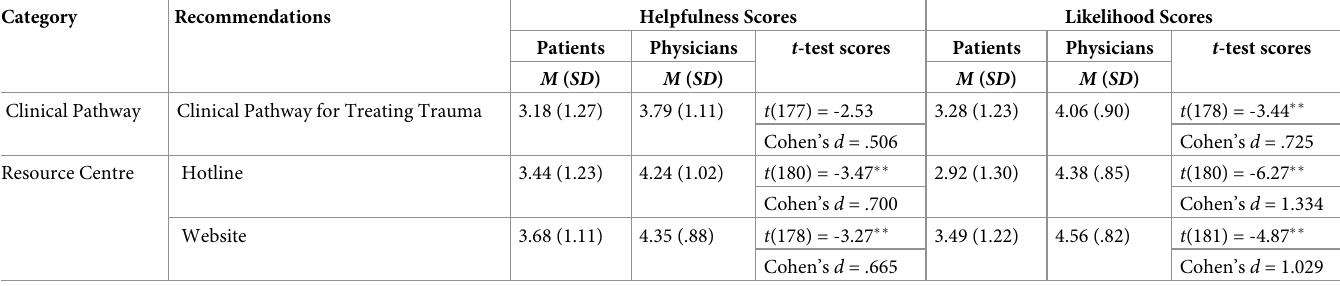
Table 8. Independent t -tests comparing patients’ and physicians’ scores on clinical pathway and trauma resource